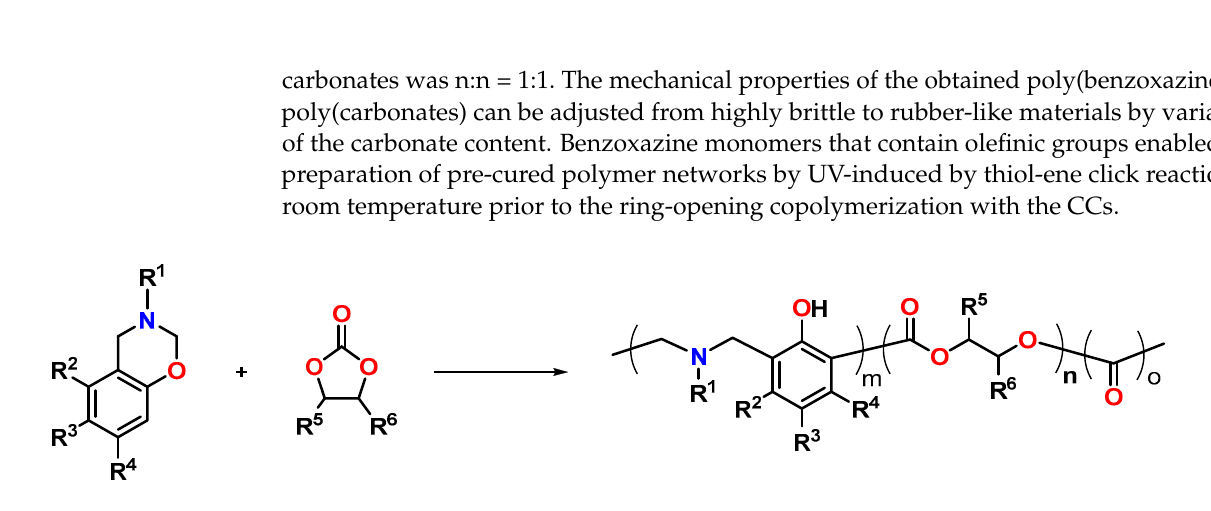
1.44 were obtained.